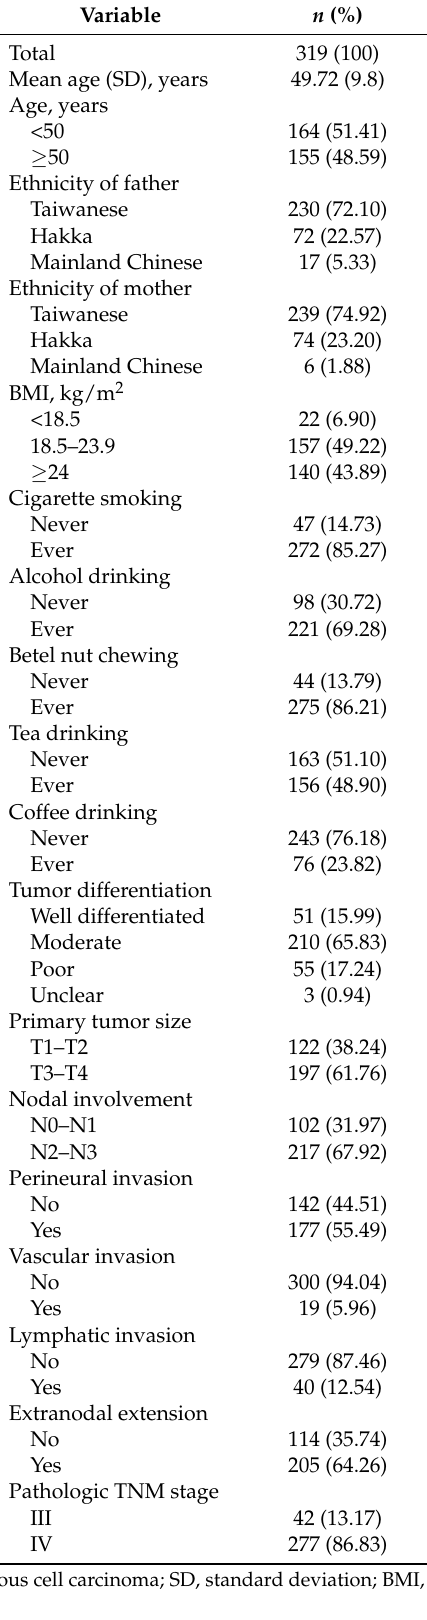
Table 1. Demographic and clinical characteristics of patients with oral squamous cell carcinoma (OSCC) treated with concurrent chemoradiotherapy